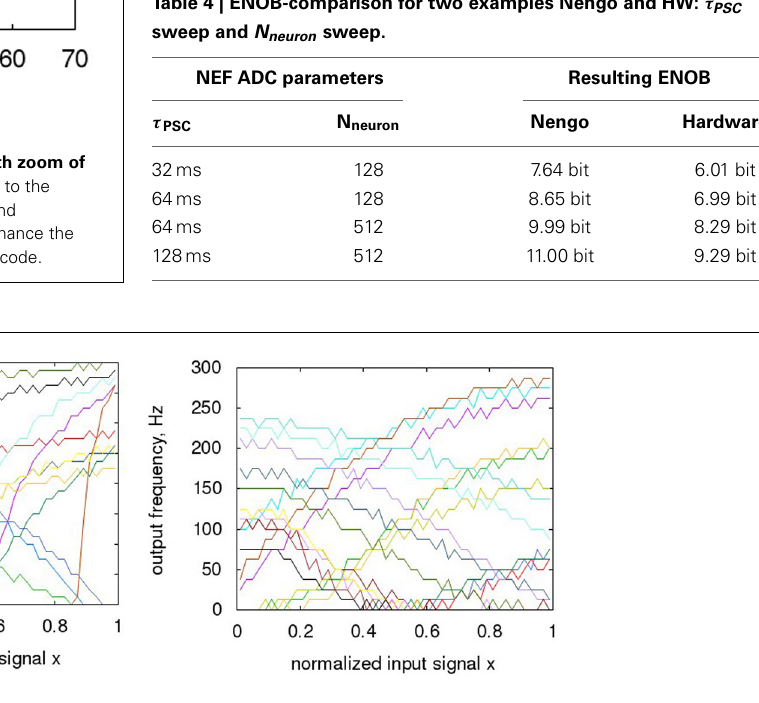
FIGURE 11 | Variation of neuron tuning curves; (A) Nengo; (B) hardware. For the hardware Monte Carlo variations, only mismatch is activated, as expectedonasingledie,i.e.,noprocessdeviations.Pleasenote:themaximum